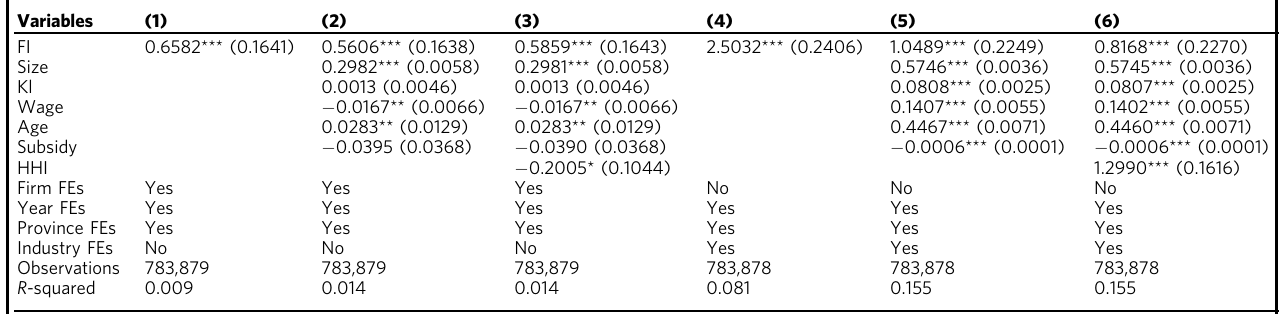
Table 2 Baseline results.